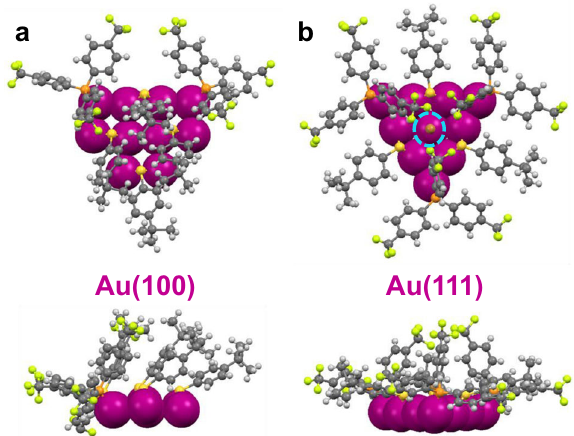
Fig. 4 The surface ligand distribution and protection of the Au 56 NC. Two views of ligands ’ assembly on a Au(100) facet, and b Au(111) facet of Au 56 . Color labels: magenta = Au, brown = Br, orange = P, yellow = S, gray = C, white = H, and green